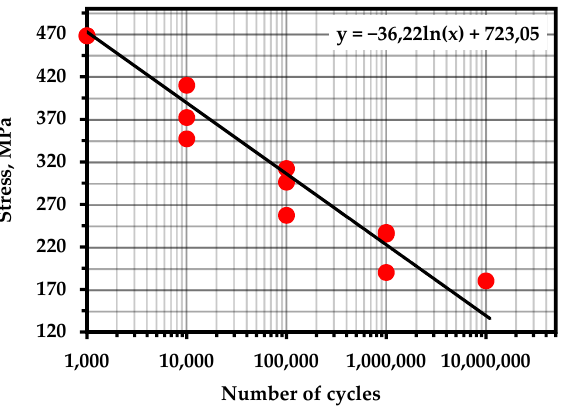
Figure A8. S–N Curve—A516 Grade 70 Steel (Accepted as an analogue of SA333) (Temperature— 293 K; frequency—30 Hz). Source—Base Total Material.